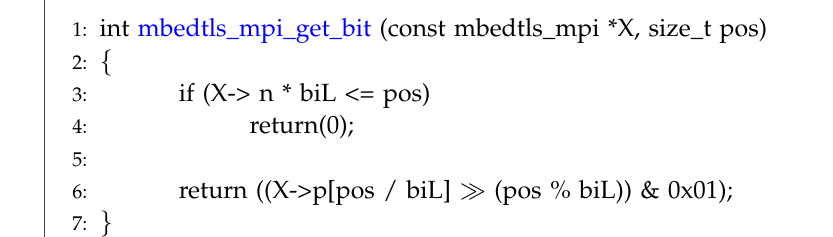
Figure 10. Key bit identification function of mbedTLS.